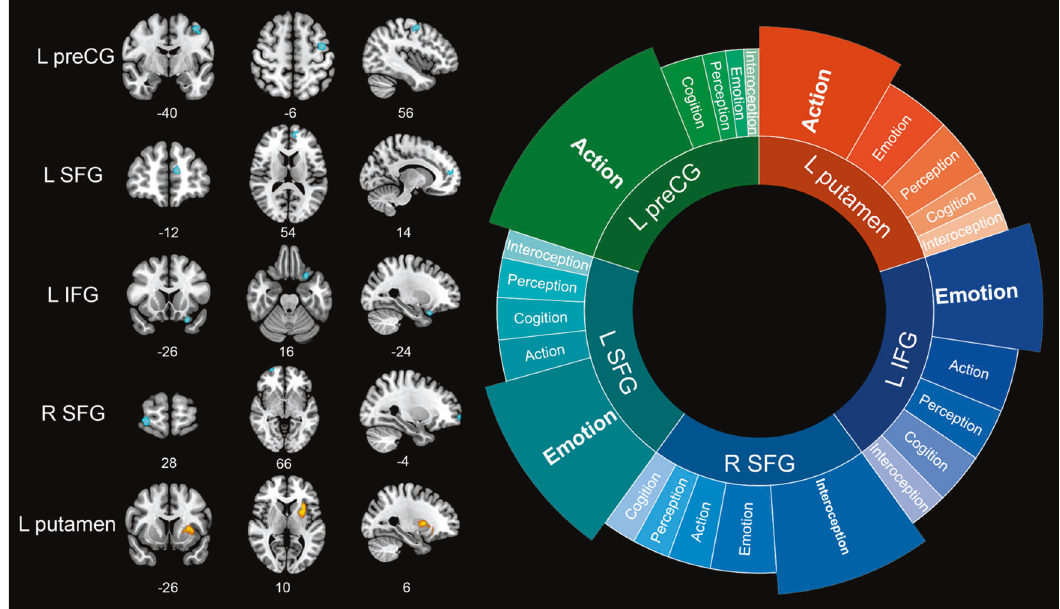
Fig. 2 Brain abnormalities of attention de fi cit/hyperactivity disorder (ADHD) and substance use disorders (SUDs) relative to controls and their corresponding functioning. Clusters were exhibited in the sagittal, axial, and coronal planes at p < 0.001, z > 1, and cluster size > 10 voxels. Increased GMV patterns (SUDs) were shown in orange while decreased patterns (ADHD) in blue. Results of functional decoding presented contribution of each behavioral domain to each suprathreshold cluster. L Left, R Right, preCG Precentral gyrus, SFG Superior frontal gyrus, IFG Inferior frontal gyrus.